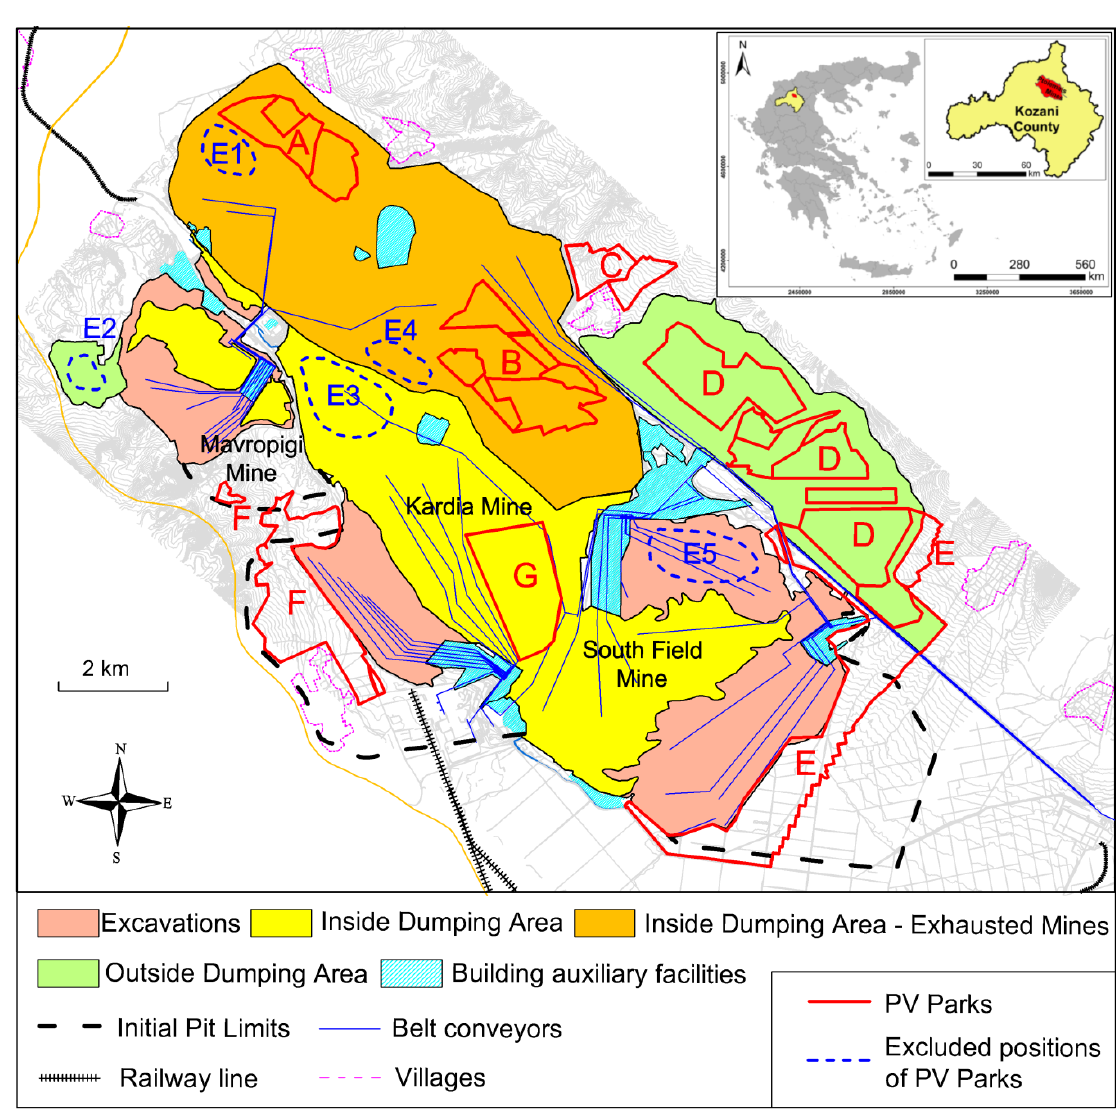
Figure 1. General overview of the study area and locations investigated for PV parks.